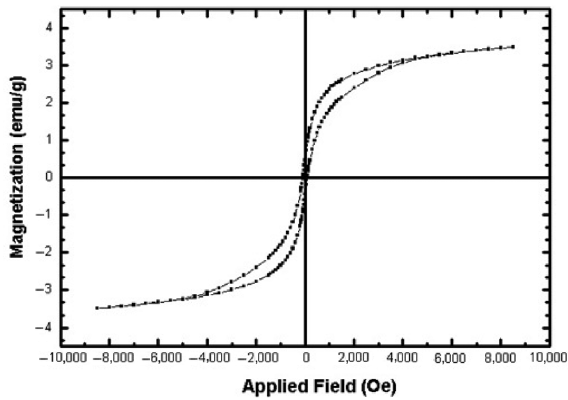
Figure 9: Magnetization hysteresis loops of the BiFeO 3 NPs prepared by microwave method.